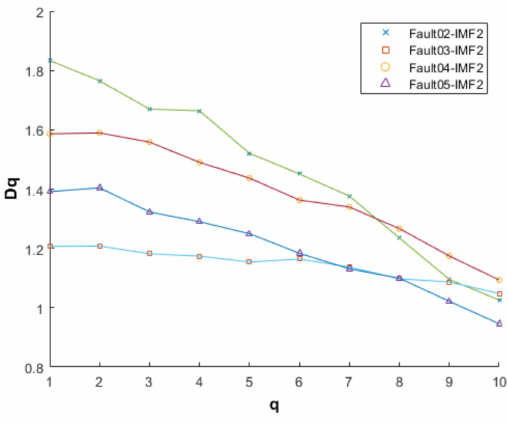
Figure 18. IMF2‑VMD mathematical morphology fractal dimension map. Table 3. Characteristic sample of the fault signal analysis